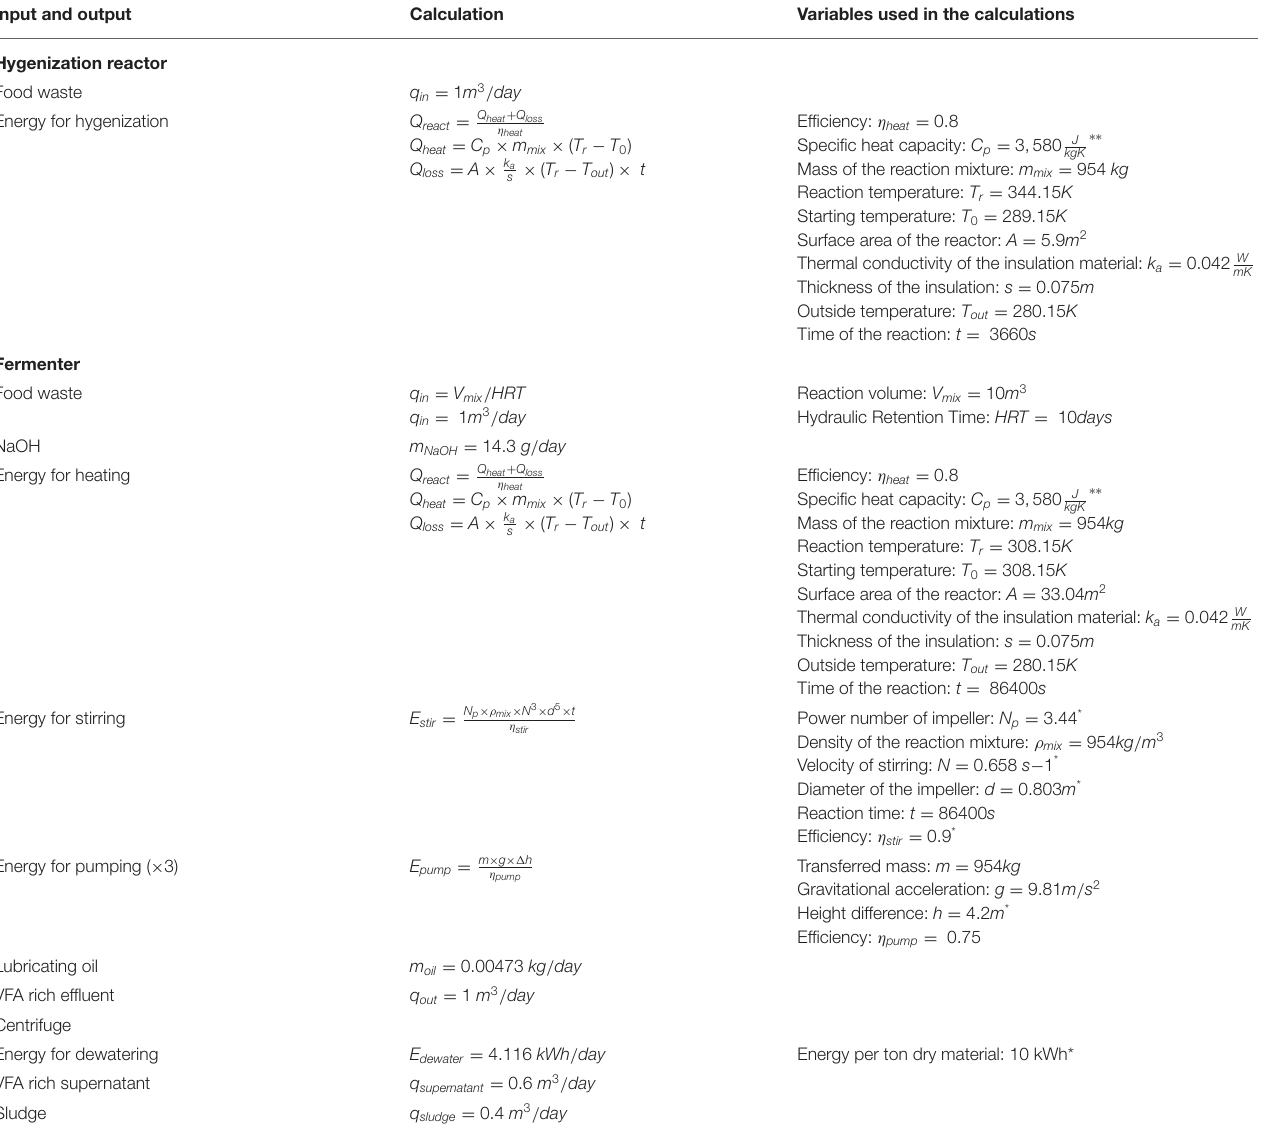
TABLE 2 | Summary of up-scaling calculations. Input and output Calculation Variables used in the